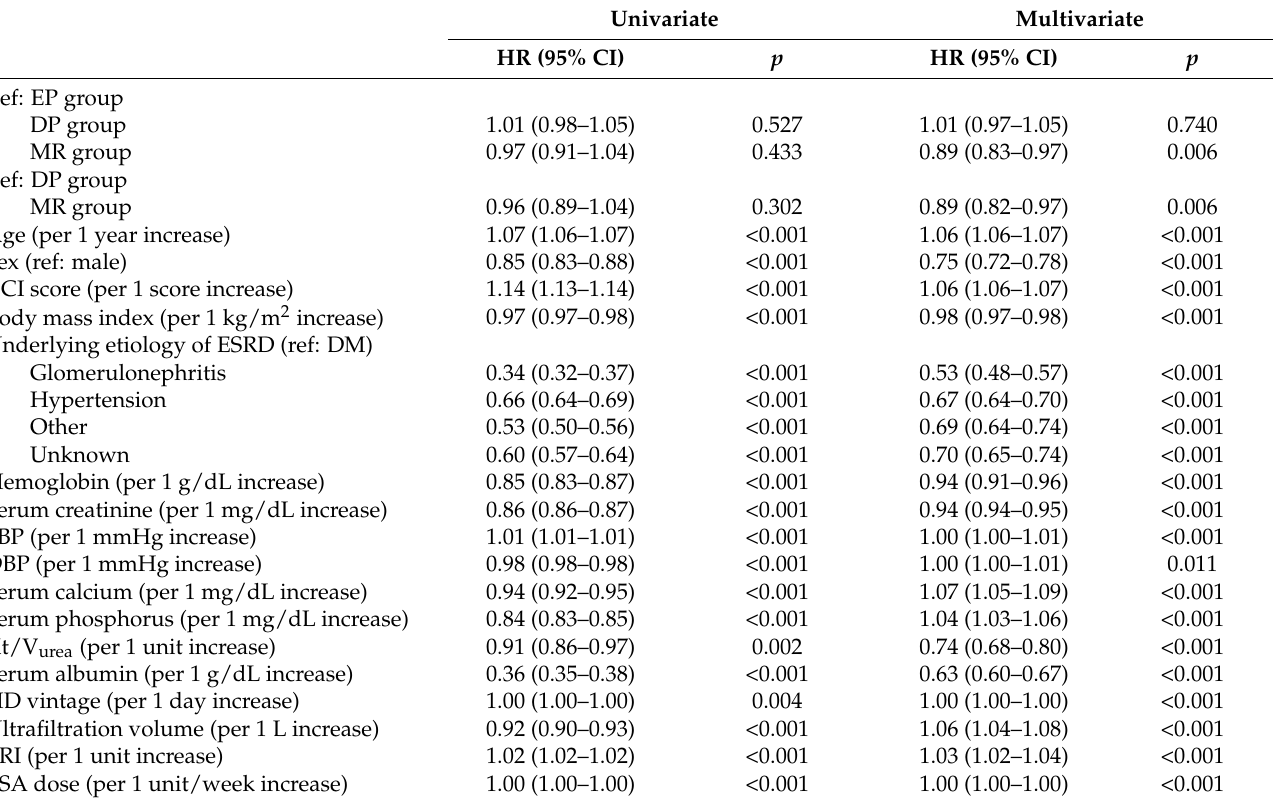
Table 2. Cox regression analyses of survival of HD patients. Univariate